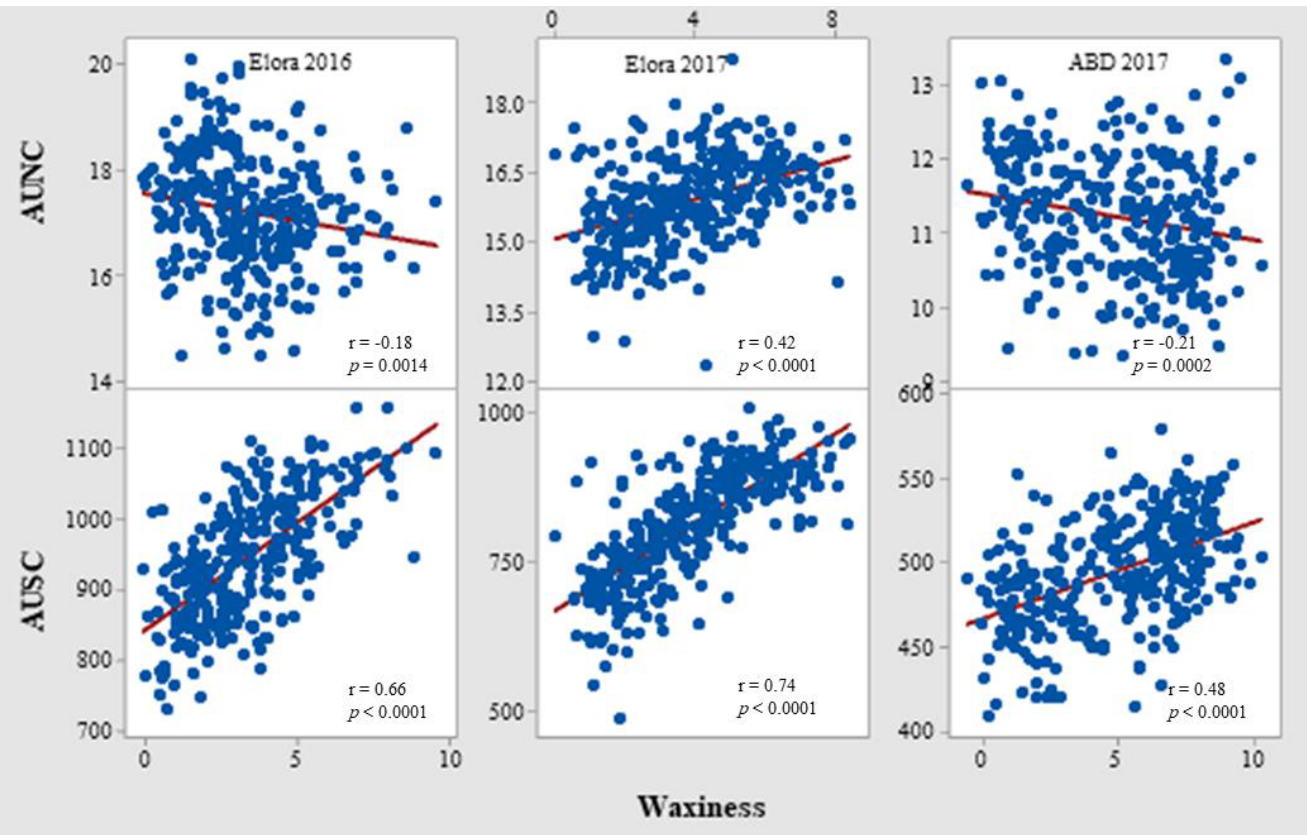
Figure 4. Scatterplots of waxiness ratings and AUNC and AUSC from three field experiments conducted in 2016 and 2017 (no data was available for waxiness from the NWRP, Nepal site); Abbreviations: AUNC = Area under NDVI curve, AUSC = Area under SPAD curve.